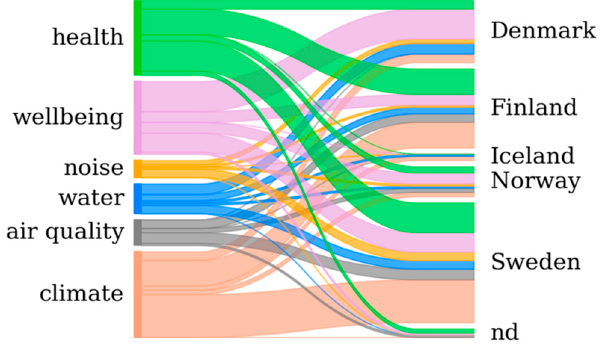
Figure 5. Distribution of research topics by country (note that papers with a multi-country analysis are counted accordingly). “nd” stands for undetermined (e.g., Northern Europe or Scandinavia) or unspecified.